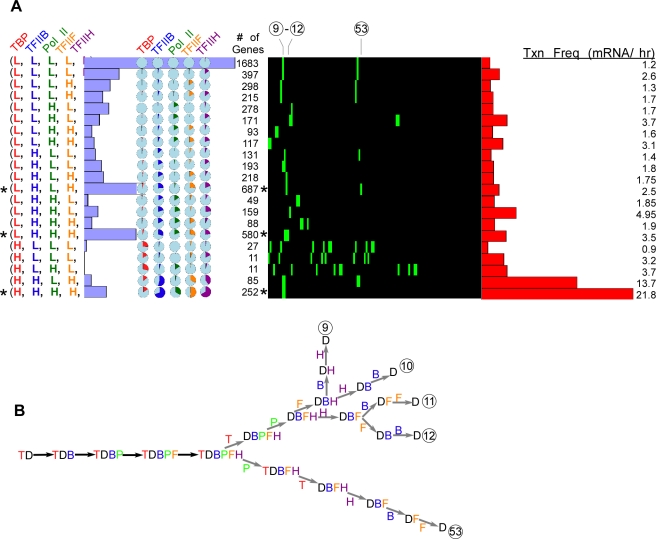
Five factor (TBP, TFIIB, Pol II, TFIIF, and TFIIH) modeling of genome-wide ChIP occupancy data.
A–B, See Figures 1 and 2 for panel descriptions.